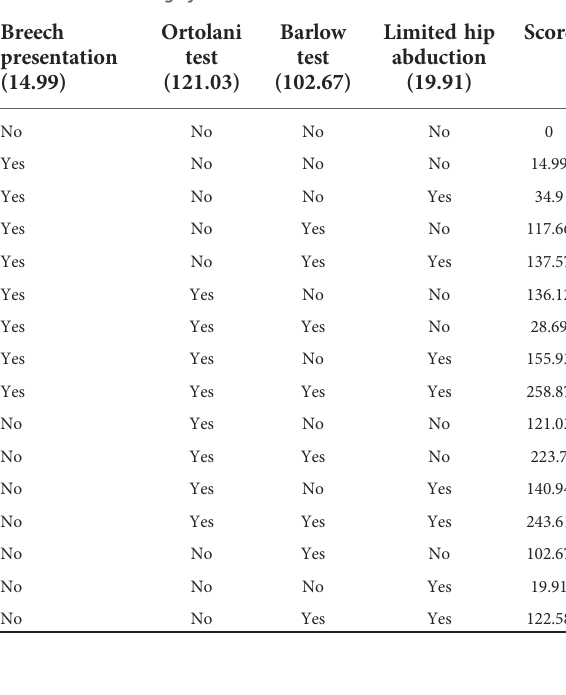
TABLE 6 The scoring system.